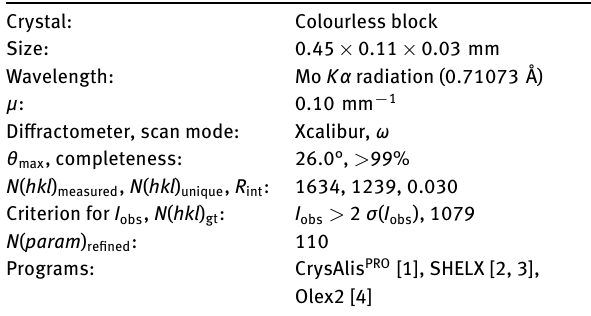
Table 2: Fractional atomic coordinates and isotropic or